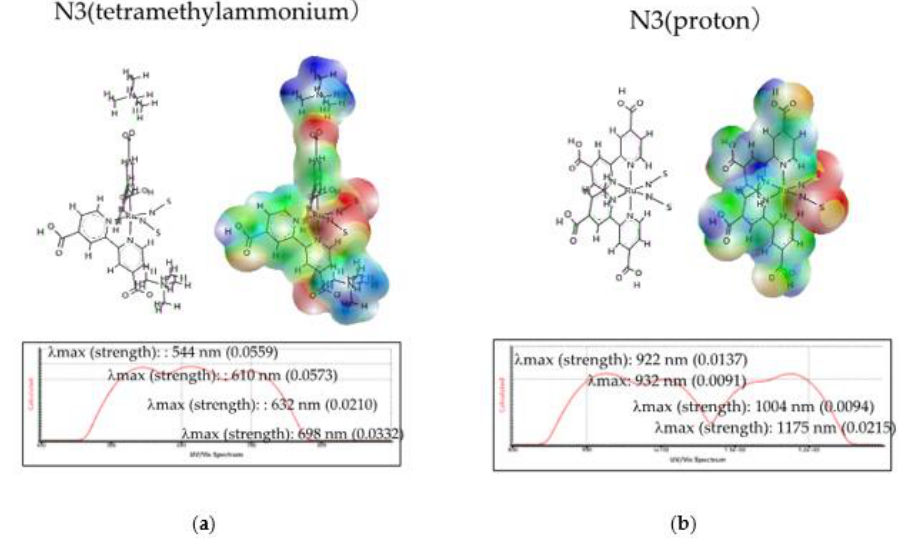
Figure 7. Electrostatic potential map and energy structures of N3 dyes: ( a ) N3 (tetramethylammonium); ( b ) N3 (proton).